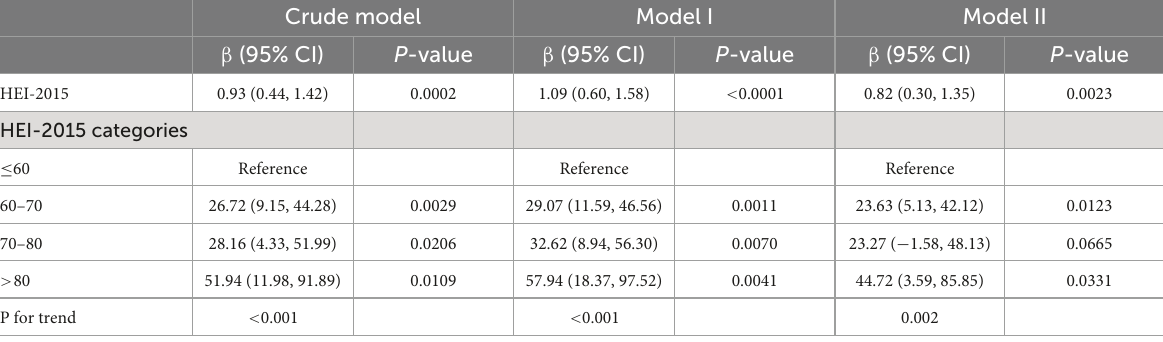
TABLE 3 Relationship between Healthy Eating Index (HEI)-2015 and S-Klotho.